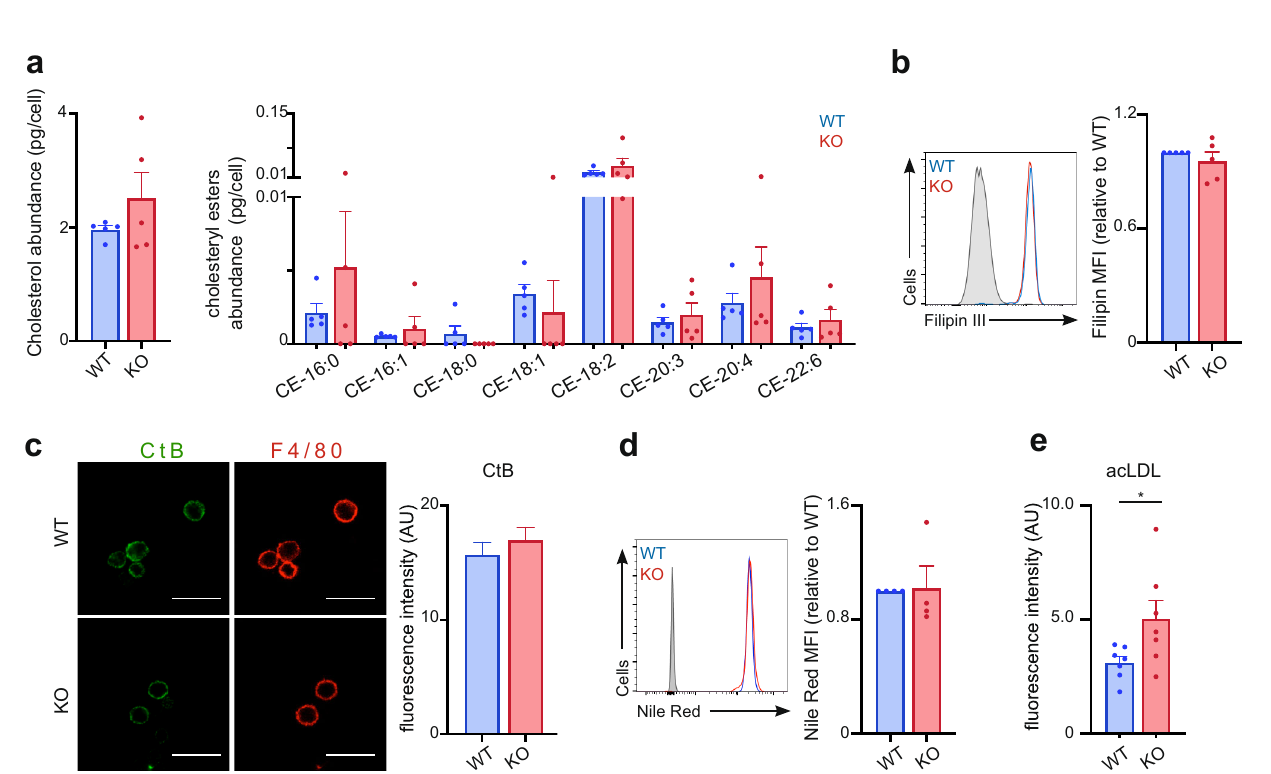
cholesterol biosynthesis pathway, showing metabolites and enzymes responsible for the individual synthetic step. Enzymes encoded by genes signi fi cantly down- regulatedinCD1d-KOpMacsareshowninblue. b – f qPCRanalysesshowingrelative expression of the depicted genes in WT (blue) and CD1d-KO (red) pMacs, pMacs sort puri fi ed from 50:50 WT:CD1d-KO bone-marrow chimeras and BMDCs as indi- cated ( n =4 – 11). Bars represent mean+/ − SEM; * p <0.05; ** p <0.01; *** p <0.001, one-sample t -test. Values for n represent biologically independent samples (as shown by the number of data points in each graph). n =cells isolated from indivi- dual mice. Source data are provided as a Source Data fi le.